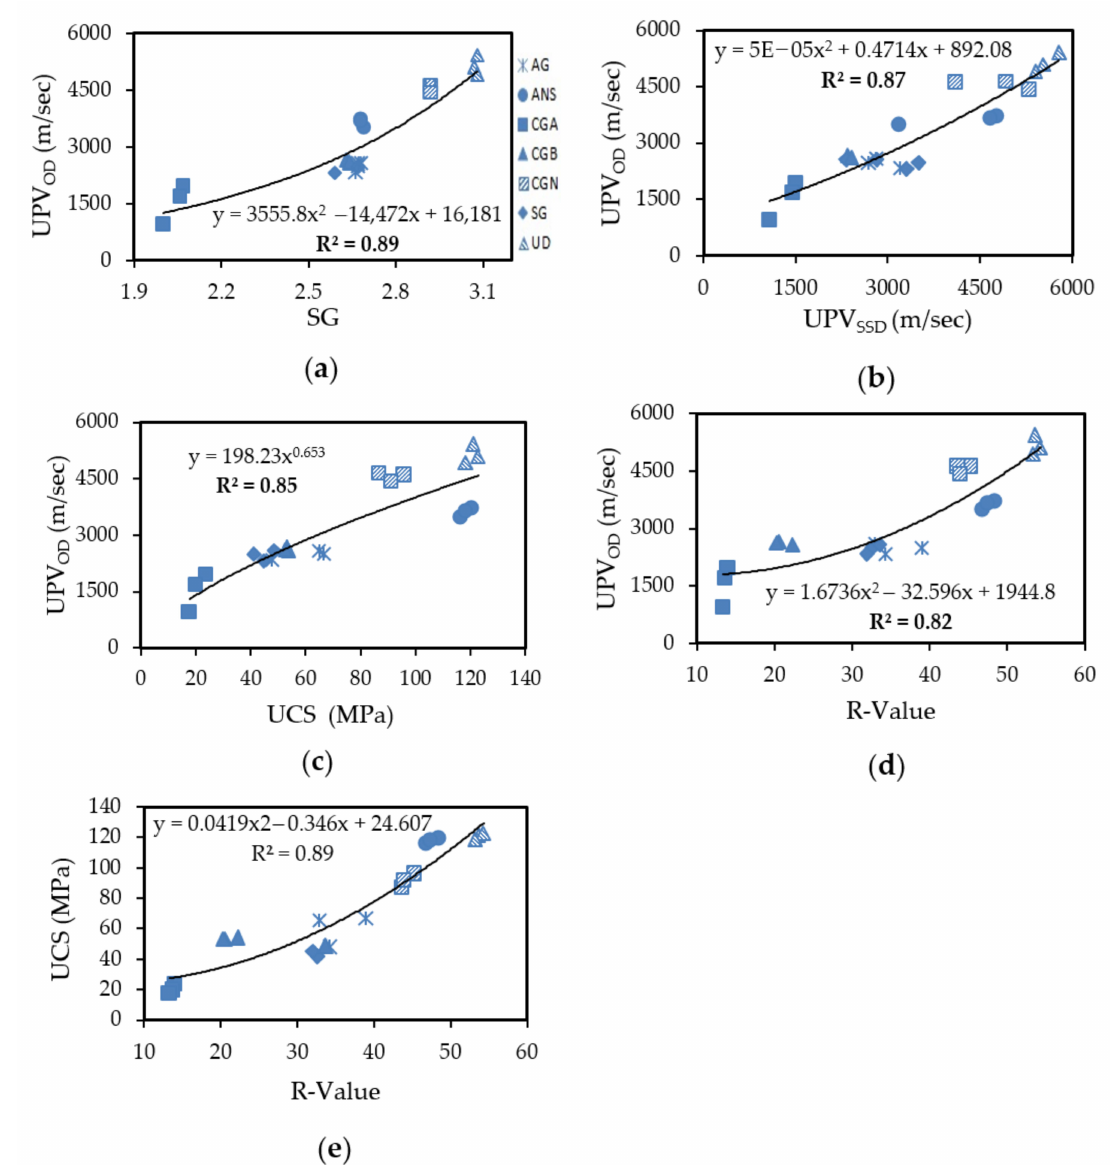
Figure 5. Correlation plots of ( a ) ultrasonic pulse velocity oven-dry (UPV OD ) vs. specific gravity (SG) (polynomial), ( b ) UPV OD vs. UPV SSD (polynomial), ( c ) UPV OD vs. UCS (power) ( d ) UPV OD vs. R-Value (polynomial), ( e ) UPV OD vs. R-Value (polynomial). Symbols given in ( a ) are the same for all